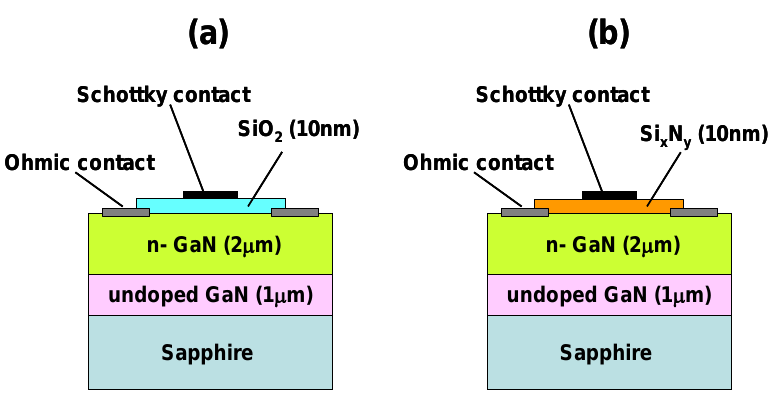
(a) and 10 nm 2 in N at room temperature. 2 2